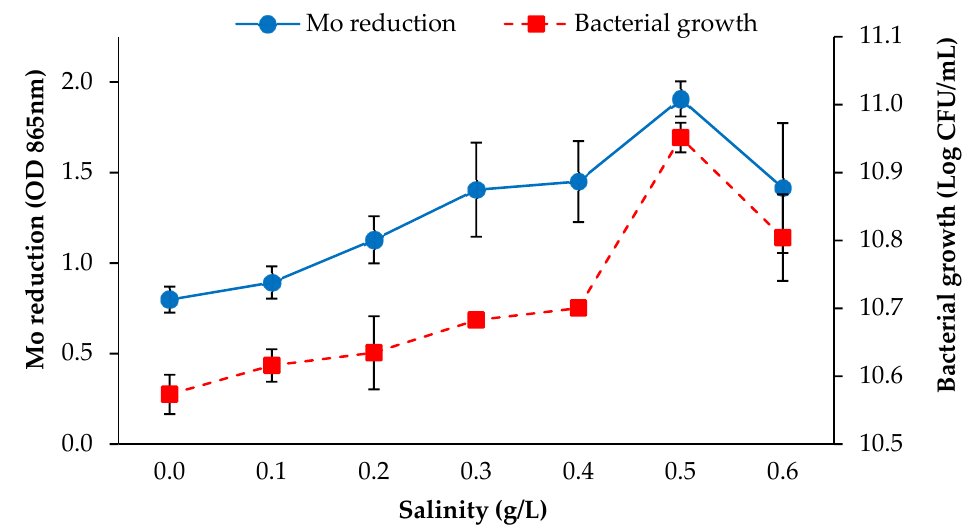
Figure 4. The effects of salinity on Mo reduction and growth activity of strain AQ5-05. The error bars represent the mean ± standard deviation for three replicates.